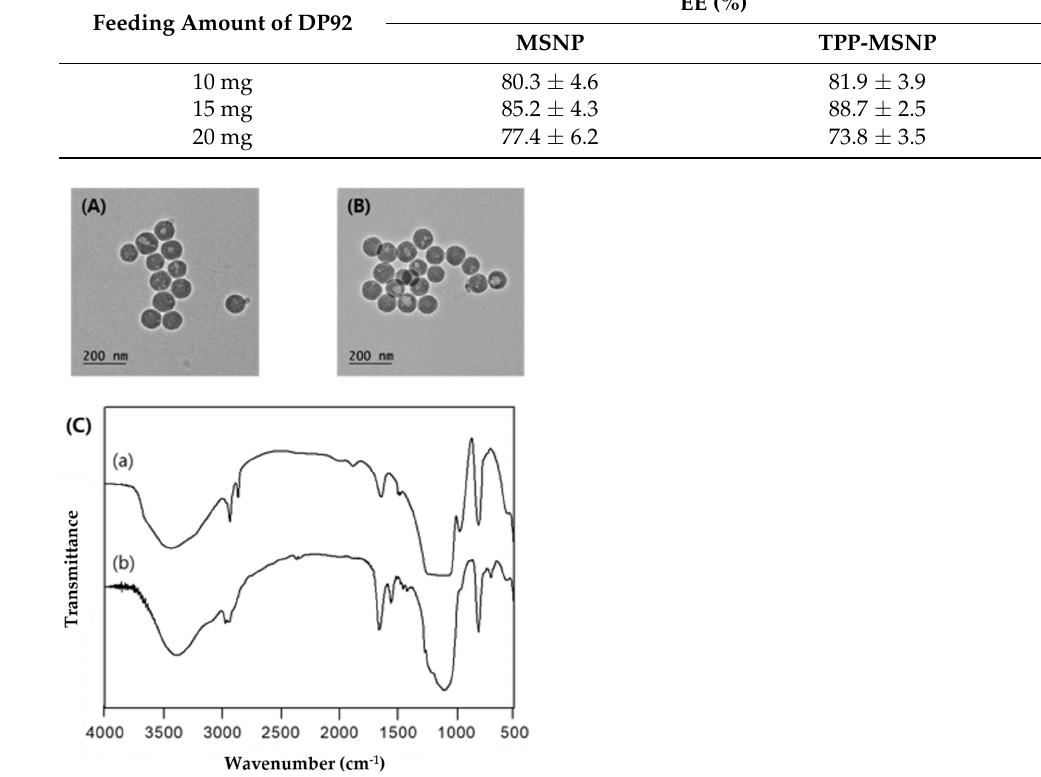
Feeding Amount of DP92 Transmission electron microscopy (TEM) images were taken to identify the morphol-